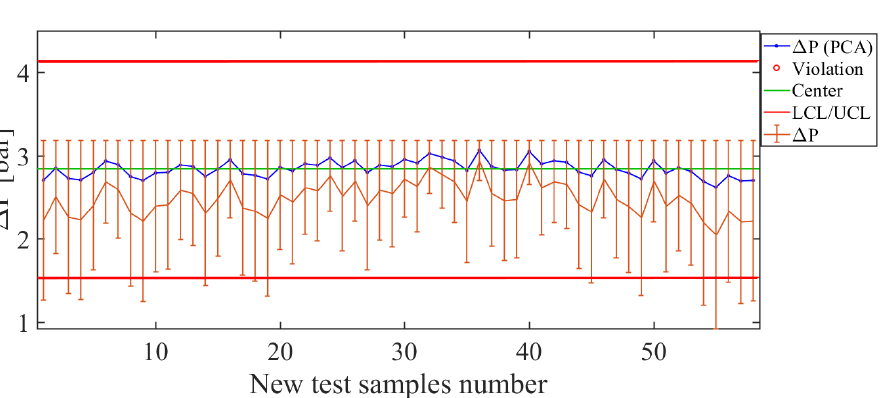
Figure 19. Soft sensor response (control chart and error bars) for the operating condition ∆ P . The magnitudes of the error bars are smaller close to the condition ∆ P = 3.0 bar.